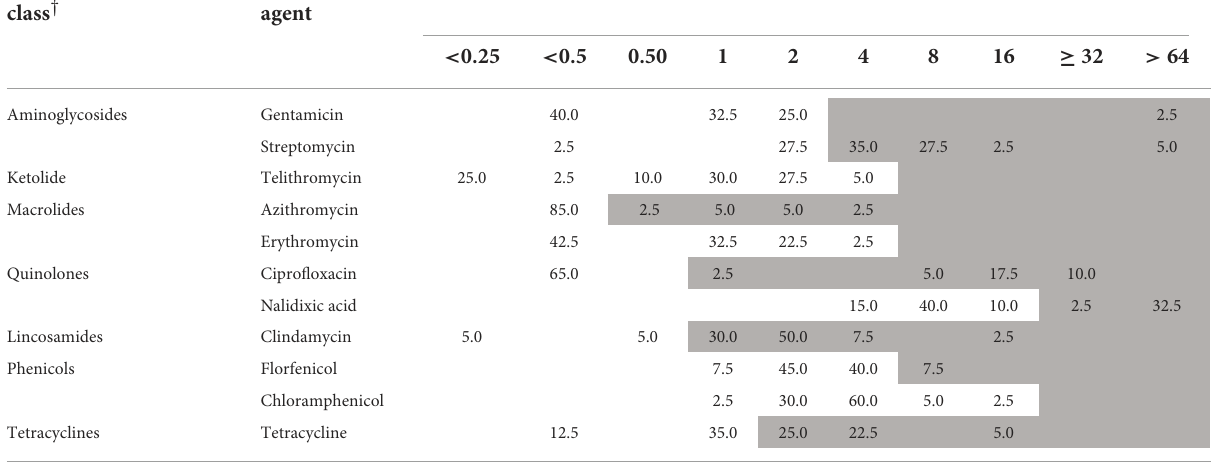
TABLE 2 MICs of antimicrobial agents to 40 A. cryaerophilus isolates. CLSI